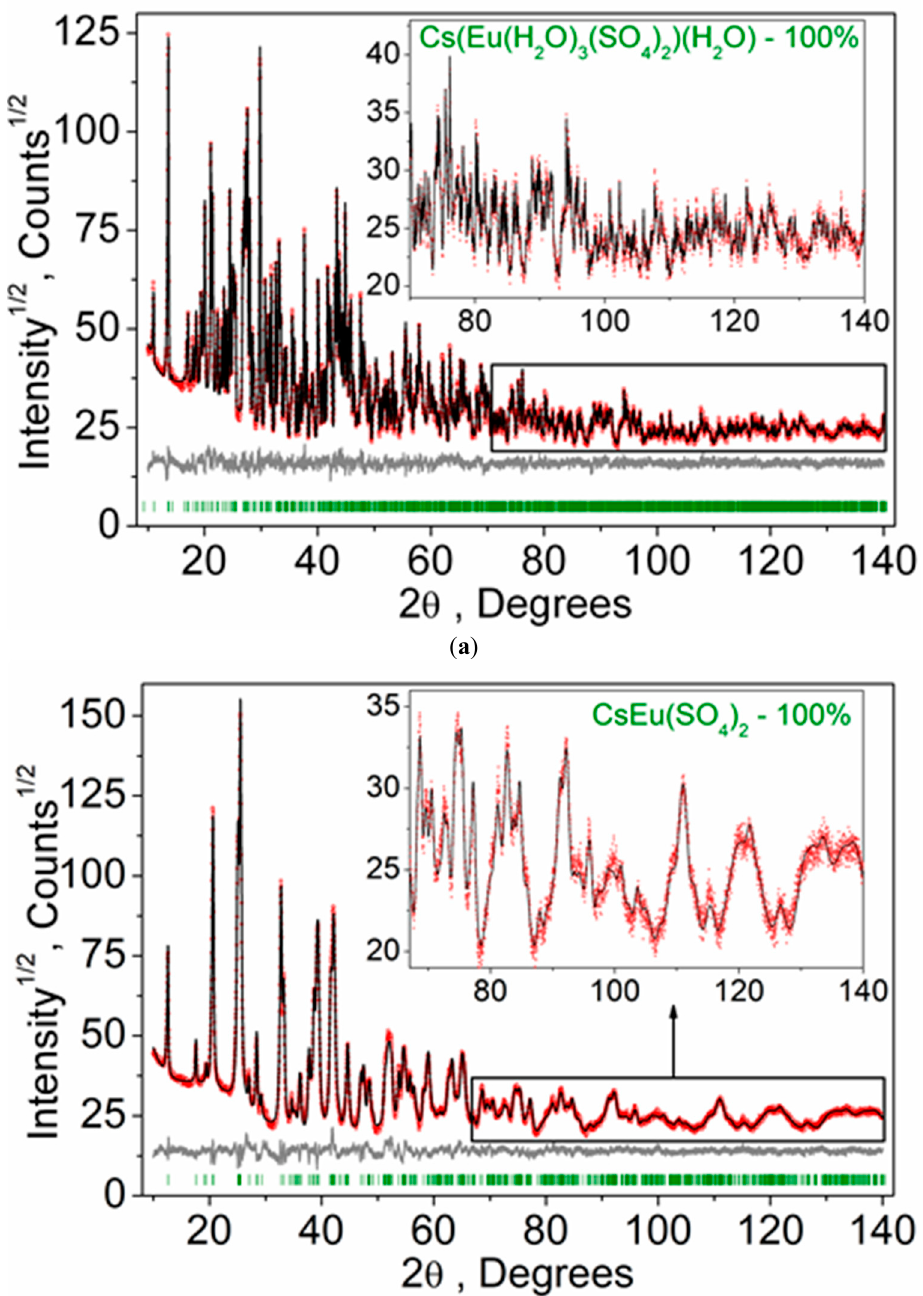
Figure 2. Difference Rietveld plots of ( a ) [CsEu(H 2 O) 3 (SO 4 ) 2 ]·H 2 O and ( b ) CsEu(SO 4 ) 2 .